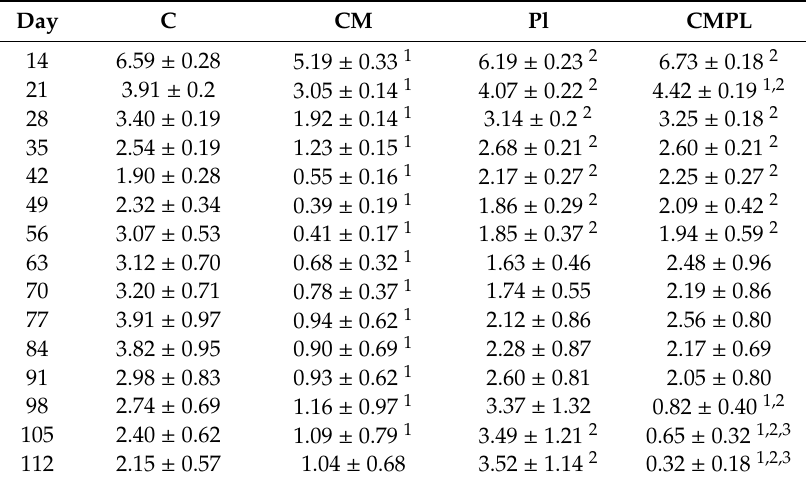
Table 2. Area of open wound surface of animal skin in LRI (cm 2